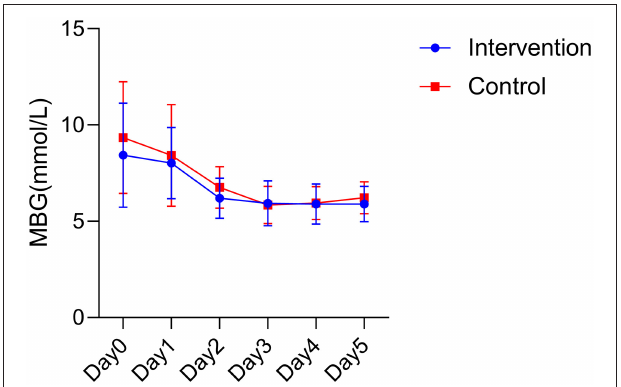
FIGURE 1 | Postoperative mean blood glucose between the two groups. MBG, mean blood glucose.